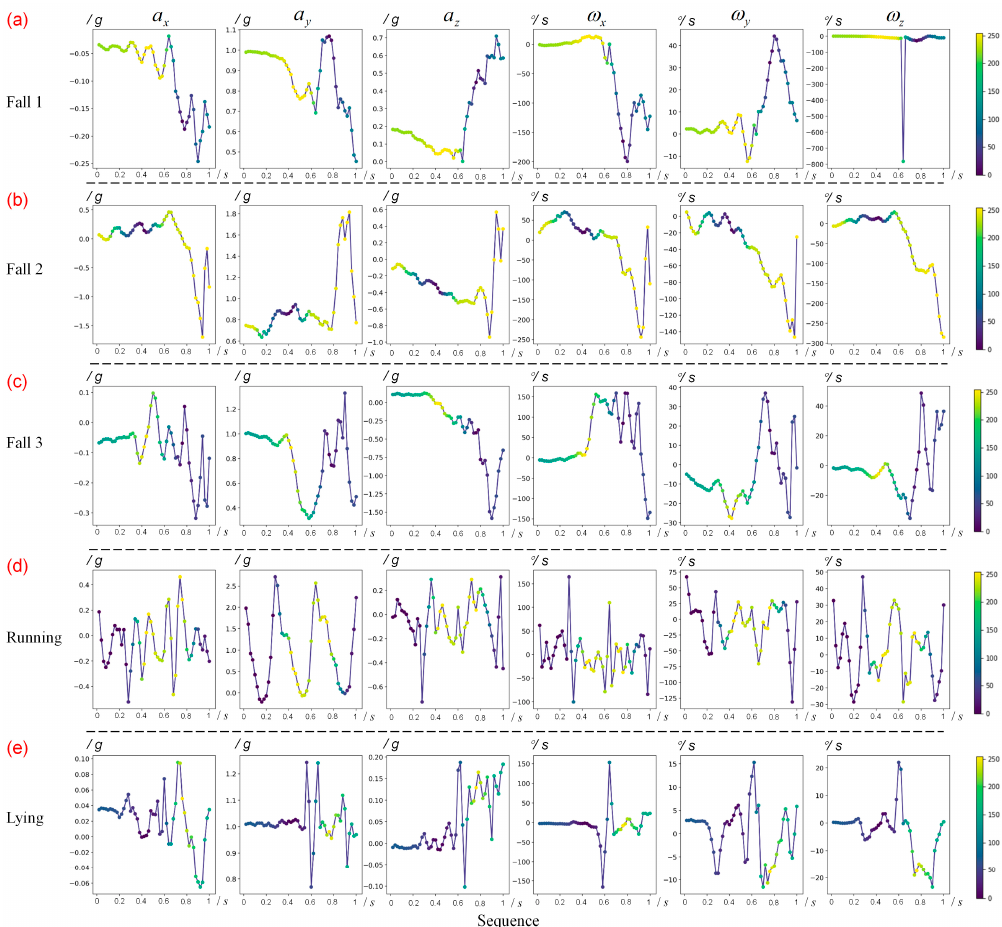
Figure 6. The hot map of five samples of real-world data. The color bar indicates the importance of regions in the sequence for classification. a x , a y , and a z represent x-axis, y-axis, and z-axis of acceleration, respectively. ω x , ω y , and ω z represent x-axis, y-axis, and z-axis of angular velocity, respectively. ( a ) One common fall sample. ( b ) One fall sample. Note that the impact phase is also a contributing region of this set. ( c ) One fall sample. Note that the minimum SVM in the early fall phase is less than 0.6 g (g for one gravitational acceleration). ( d ) One running sample. ( e ) One lying sample.